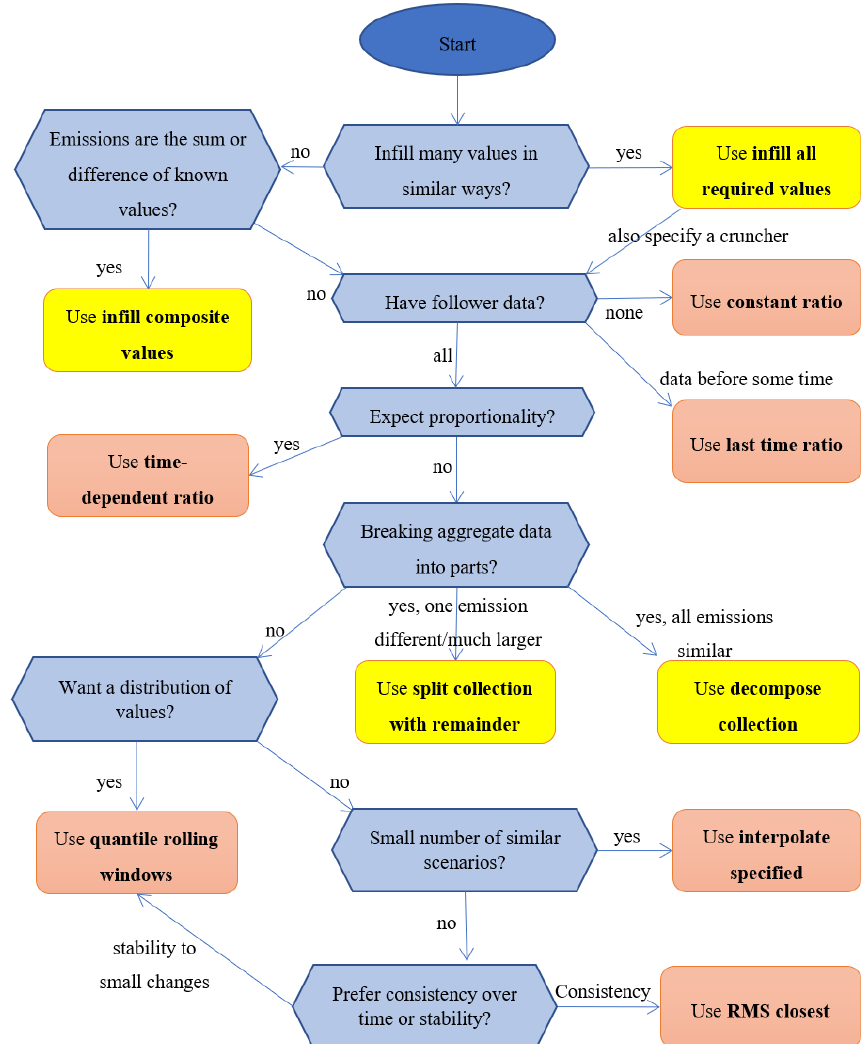
Figure 1. Flow chart suggesting how to choose the cruncher (peach oblongs) or multiple infiller (yellow oblongs) to use when